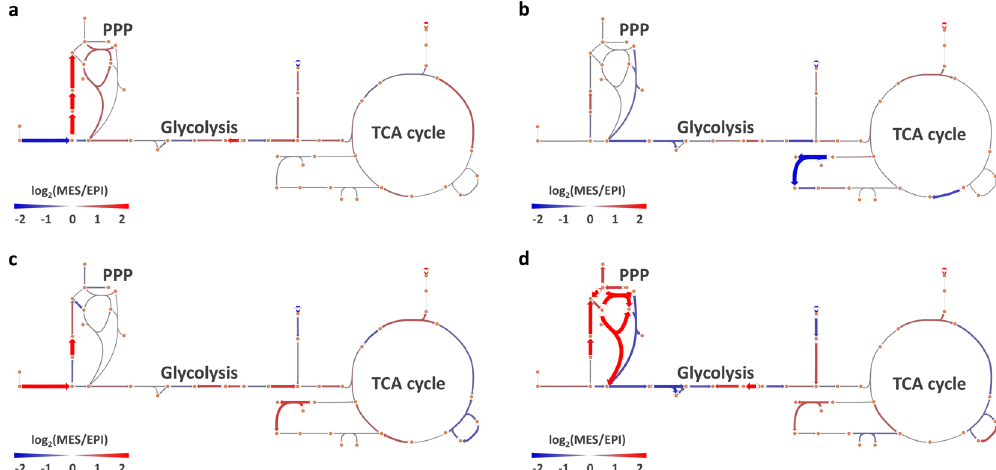
Fig. 2 Relative differences in reaction activity in EPI and MES models constrained in four different ways. a Only extracellular constraints, ( b ) Microarray, ( c ) RNA-seq and ( d ) Proteomic data. The pathways shown are glycolysis, TCA cycle, and pentose-phosphate pathway. Red represents higher activity in MES whereas blue represents higher activity in EPI, represented by log-fold differences in median activity from random sampling of the